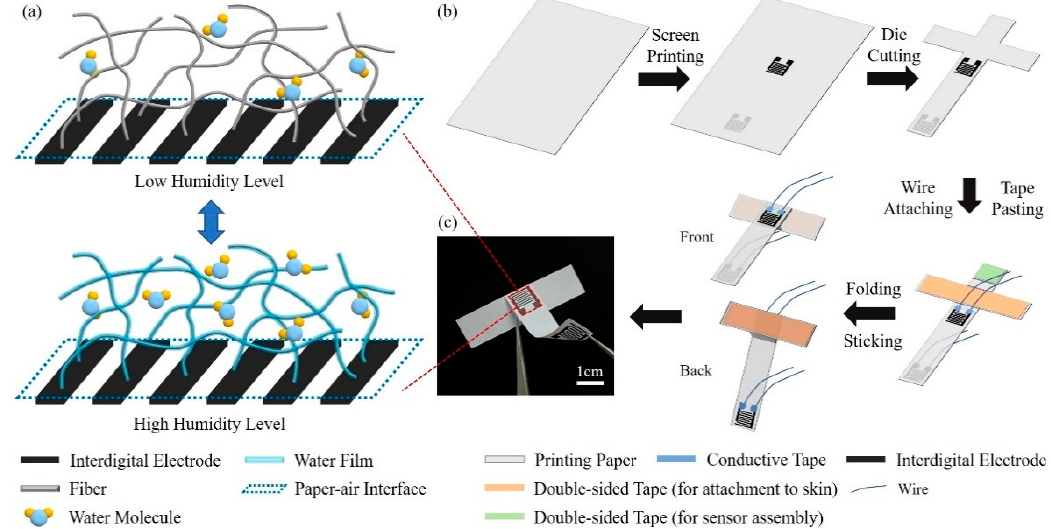
Figure 1. ( a ) Humidity sensing principle of the PHS. ( b ) Processing of designed 3D structure sensor patch. ( c ) Photo of the flexible